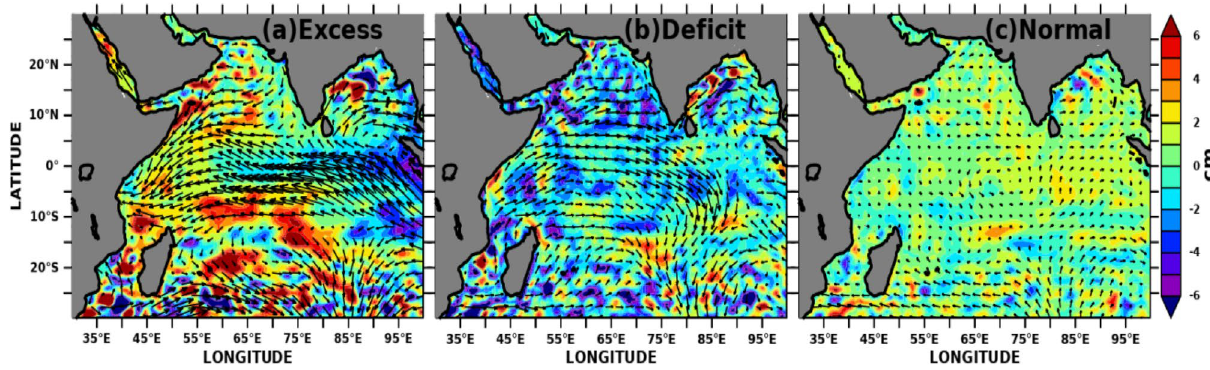
Figure 15. Composite of May month’s detrended MSLA variability (shaded) overlayed with detrended ERA5 wind anomalies (vectors) over the Indian Ocean during ( a ) excess, ( b ) deficit, and ( c ) normal monsoon years. The figure is generated using PyFerret